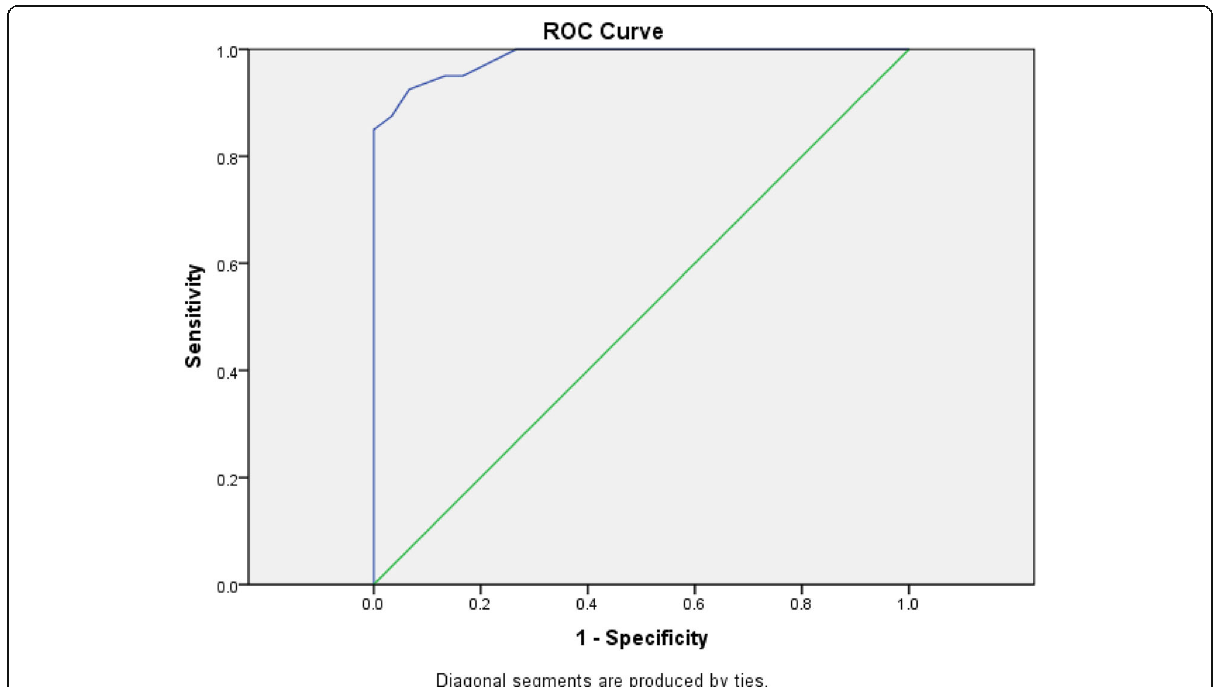
Fig. 2 Receiver-operating characteristic (ROC) curve for uterine arteries pulsatility index in discrimination of the unexplained infertility group and the fertile control group